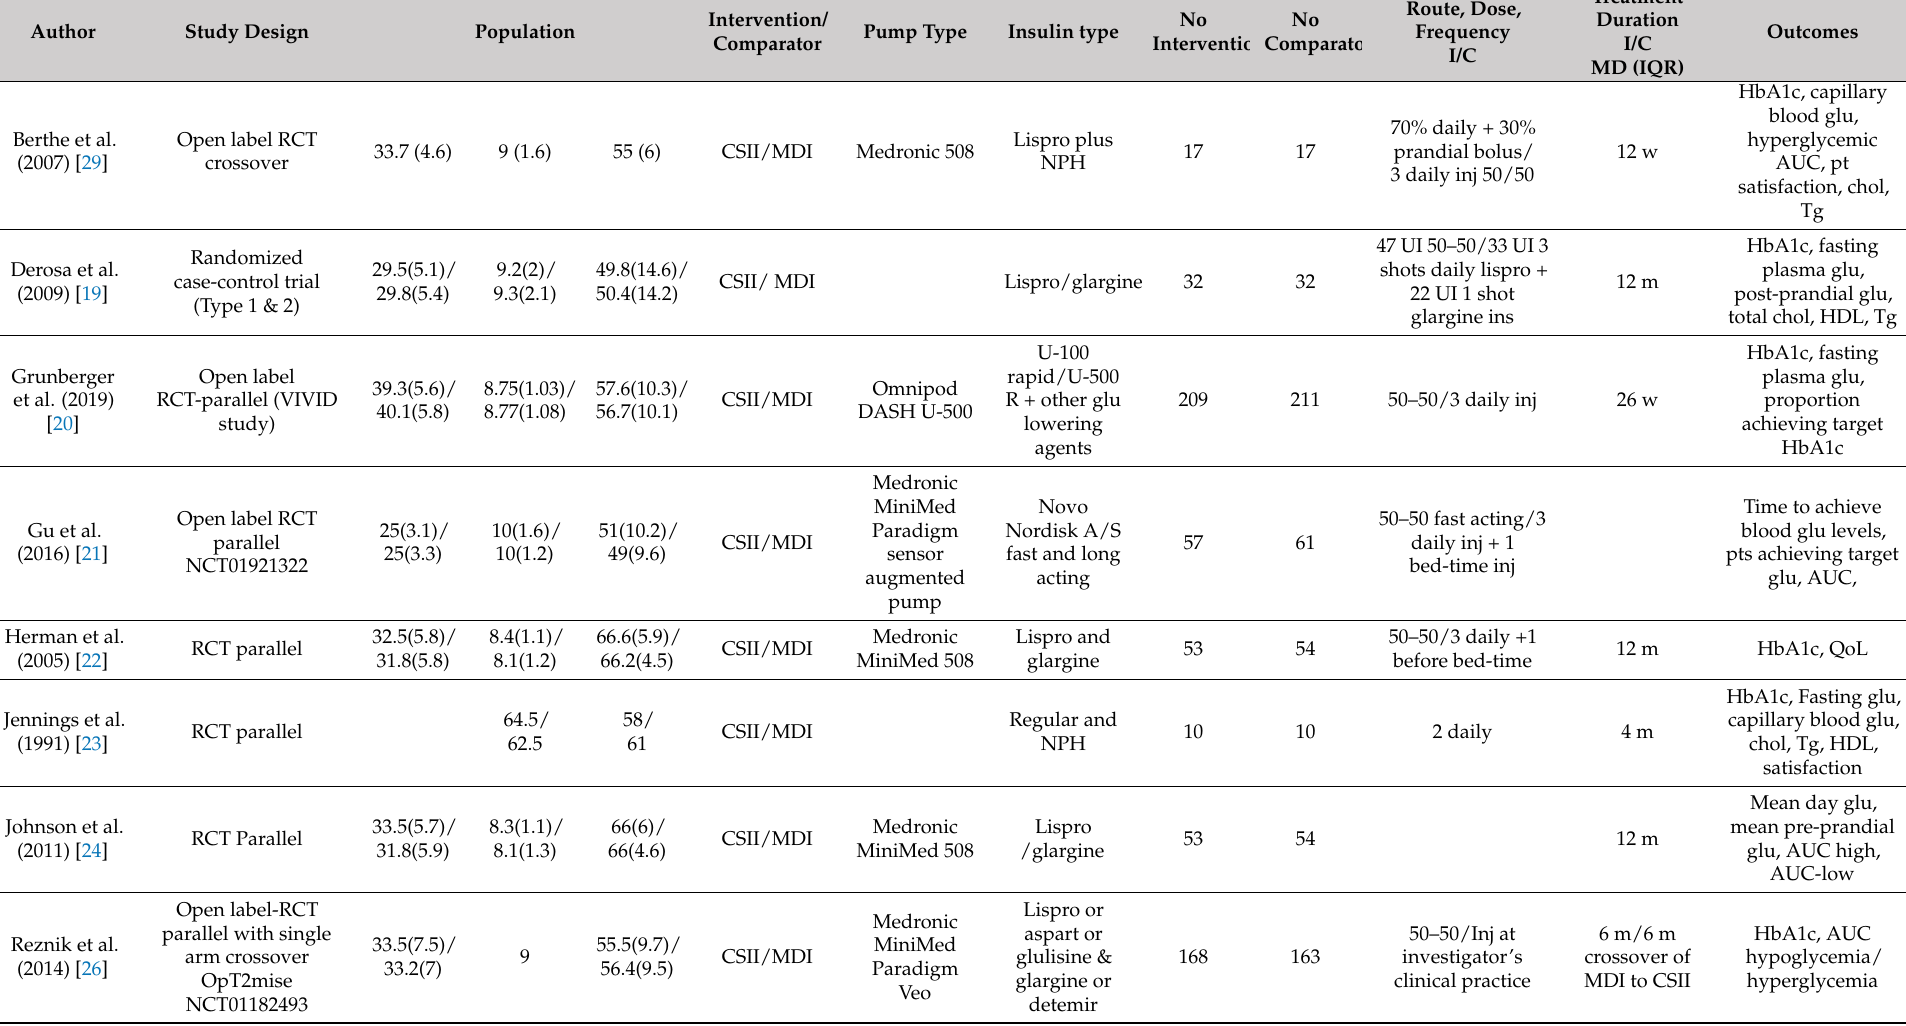
Table 3. Table of Characteristics of Included